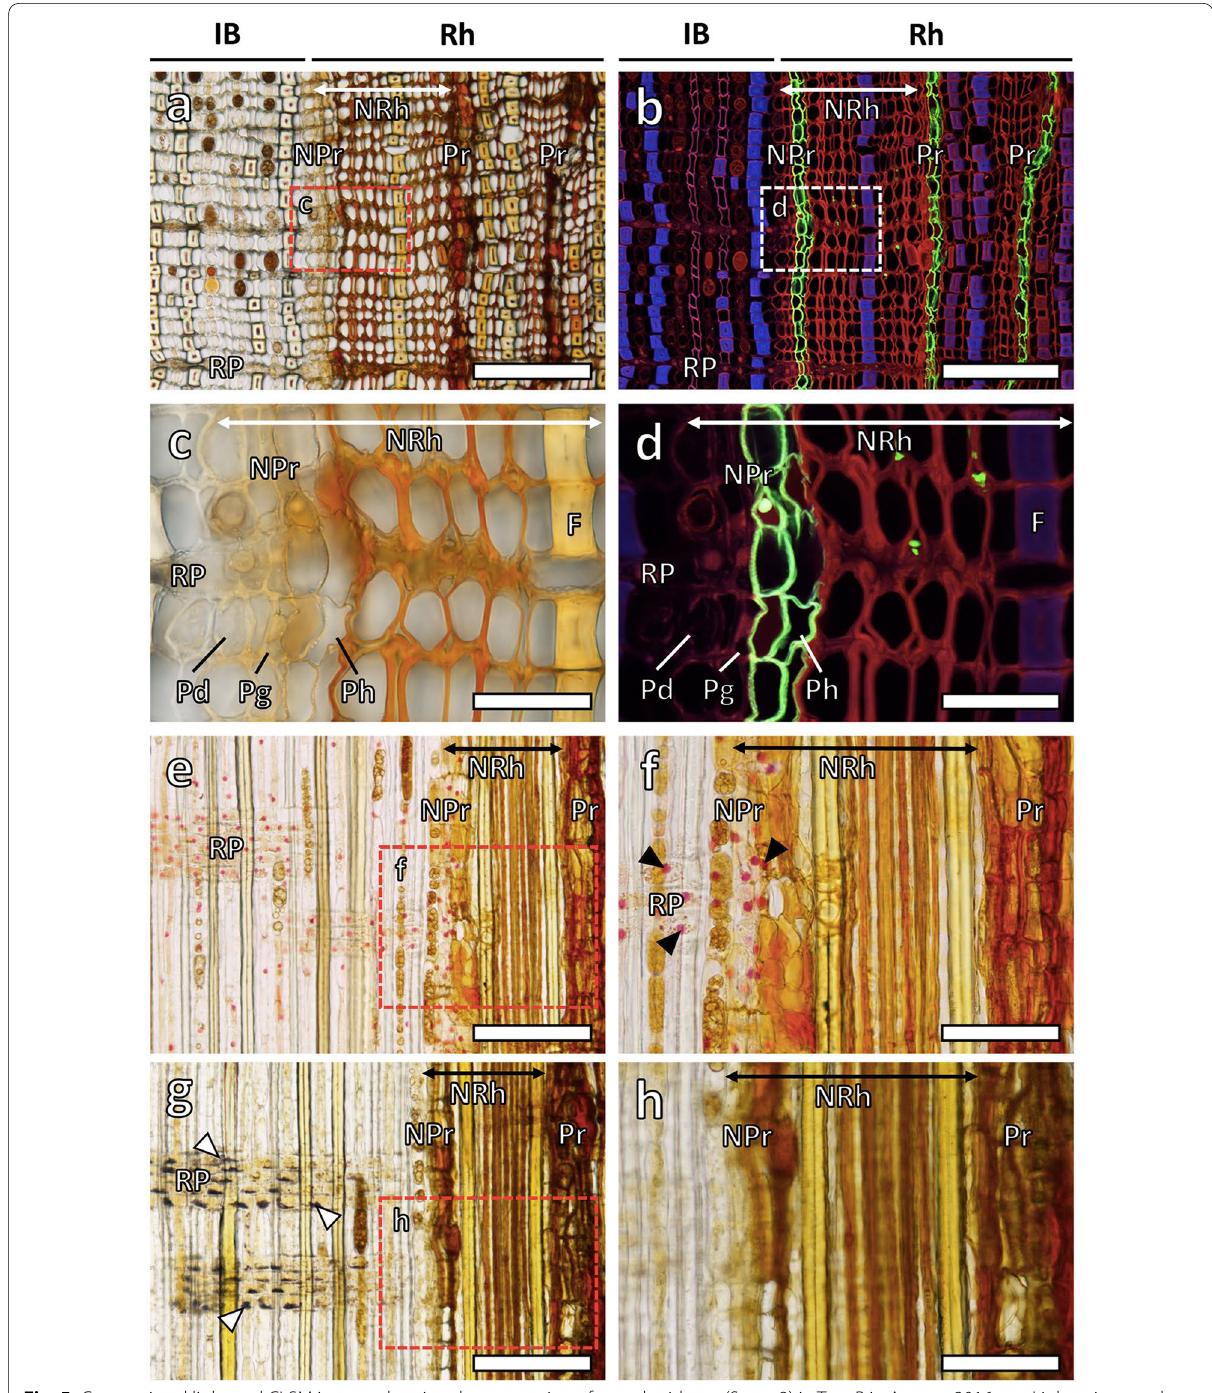
Fig. 5 Conventional light and CLSM images showing the maturation of new rhytidome (Stage 3) in Tree B in August, 2016. a , c Light micrographs of a transverse section without staining. b , d CLSM images of the same section as in a , c after stained with FY and CR. Light micrographs of radial sections stained with acetocarmine ( e , f ) and iodine–potassium iodide ( g , h ), showing nuclei and starch grains, respectively. c , d , f , h Higher magnification images of the selected areas in a , b , e , g . Black arrowheads indicate nuclei. White arrowheads indicate starch grains. F phloem fiber, IB inner bark, NPr new periderm, NRh new rhytidome, Pd phelloderm, Pg phellogen, Ph phellem, Pr periderm, Rh rhytidome, RP ray parenchyma cell. The right side of each micrograph corresponds to the outer side of the tree. Scale bars 200 µm in a , b , e , g ; 100 µm in f , h; 50 µm in c , =